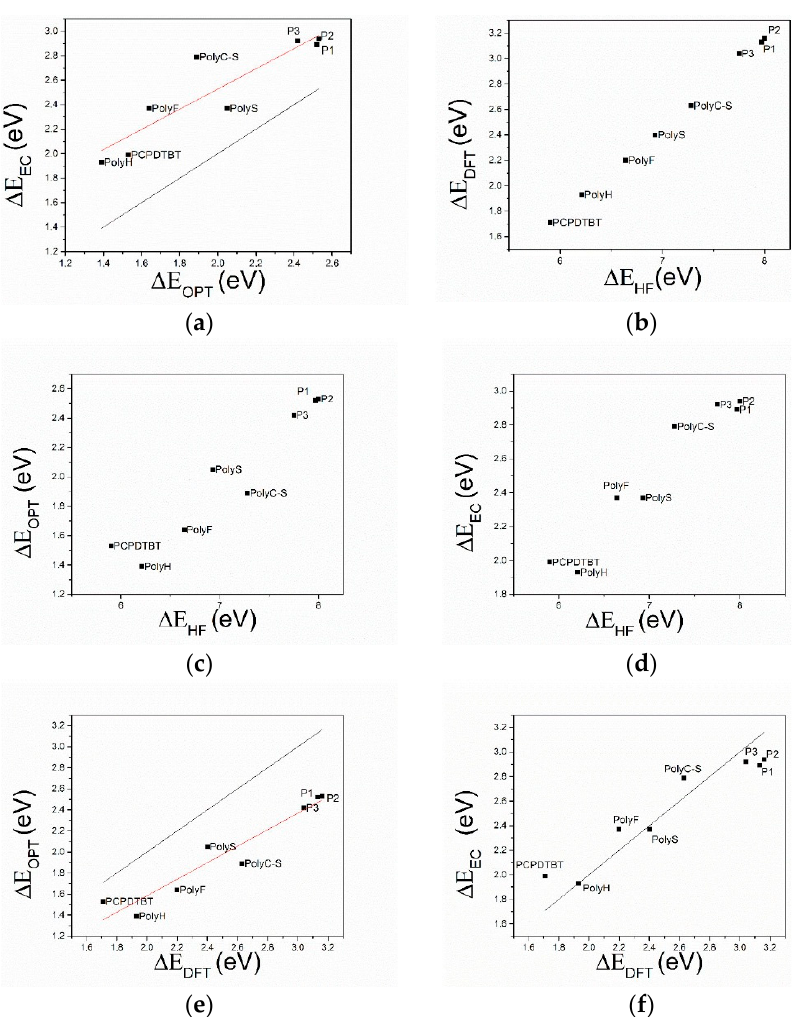
Figure 5. Comparison between ( a ) electrochemically determined and spectroscopically determined band gap; ( b ) band gap computed by means of DFT and HF methods; ( c ) band gap spectroscopically determined and computed by means of HF method; ( d ) band gap electrochemically determined and computed by means of HF method; ( e ) band gap spectroscopically determined and computed by means of DFT method; ( f ) band gap electrochemically determined and computed by means of DFT method. All data are reported in eV. The “equivalence line” shows the ideal line featuring slope = 1 and intercept = 0.